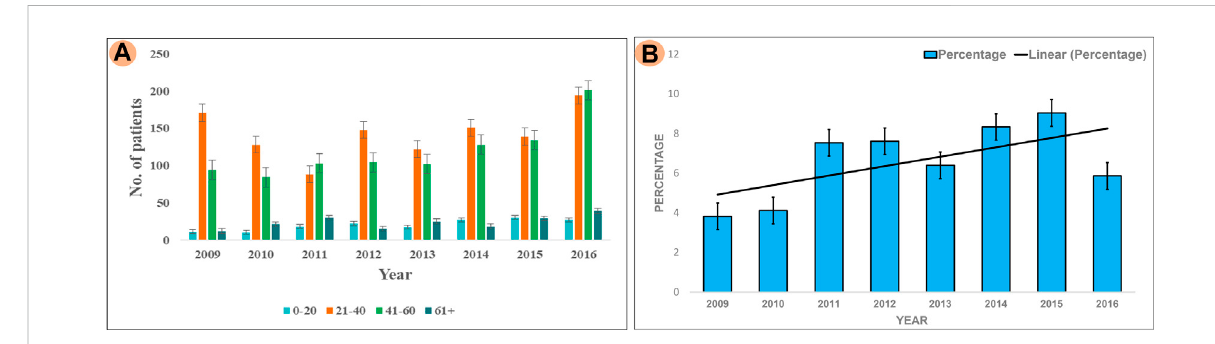
FIGURE 2 Analysis of Survey; (A) Showing prevalence of KSD in all the age groups (0 – 20, 21 – 40, 41 – 60, 60+) years per year, between 2009 – 2016 (B) Percentage of affected lower age group (0 – 20) KSD patients per year, between 2009 and